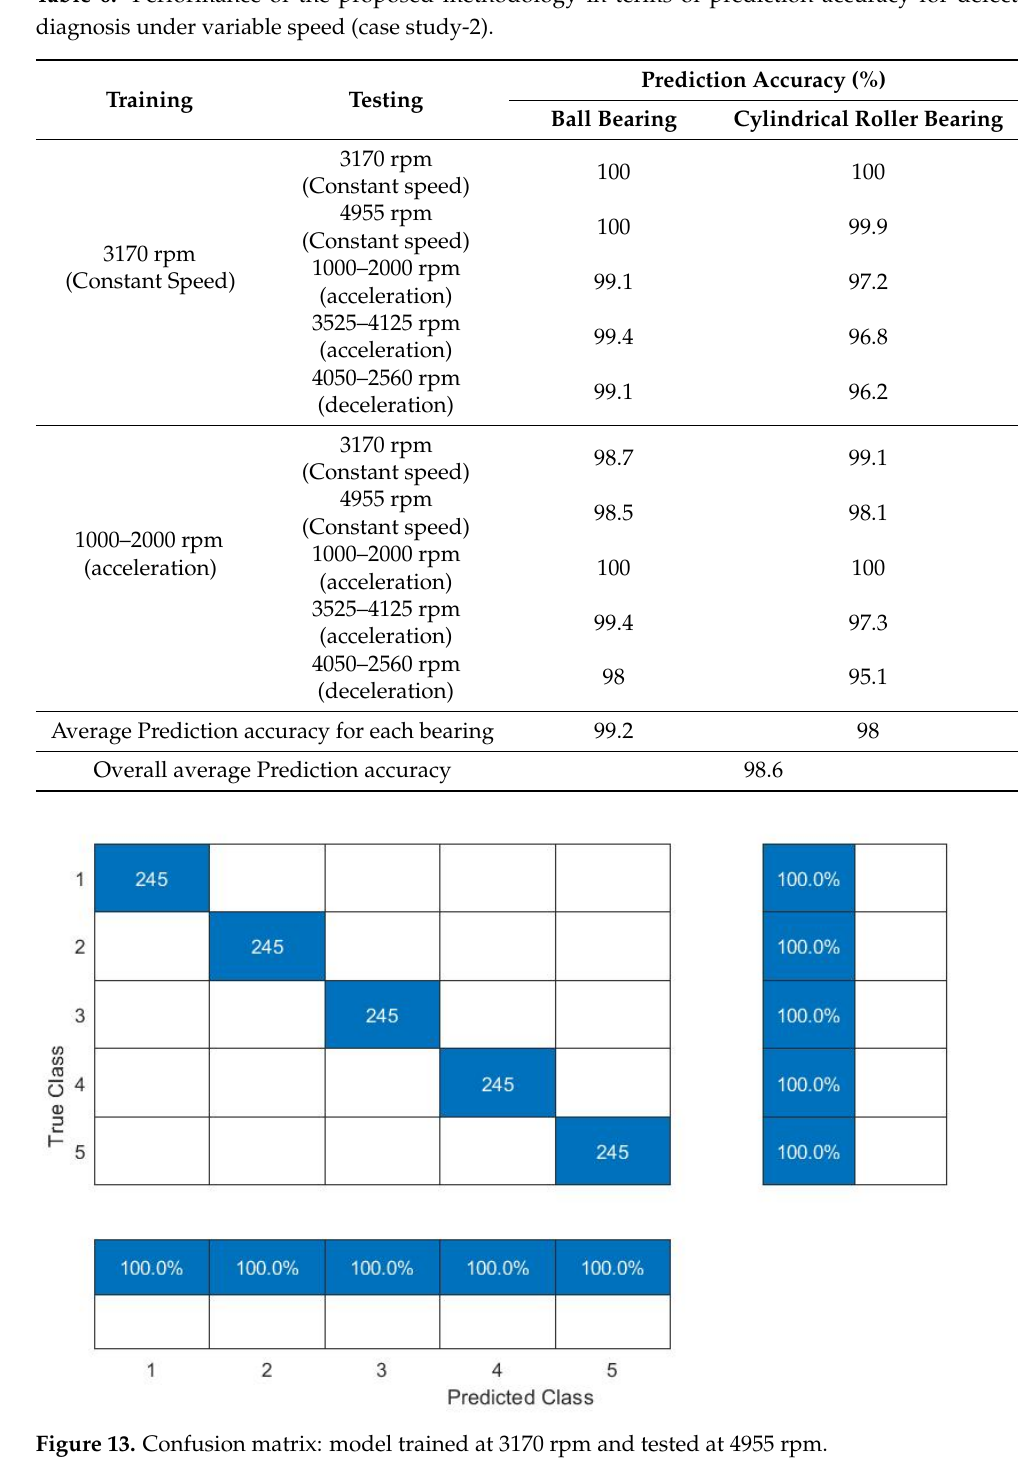
Figure 14. Confusion matrix: model trained at variable speed between 1000 and 2000 rpm and tested at variable speed between 3525 and 4125 rpm. 5. Conclusions In this study a method for the defect diagnosis of rolling element bearings under variable operating conditions (speed and load) using order maps and convolutional neural networks is proposed. A non stationery signal in the order domain. Short-time Fourier Transform of the resampled signal was computed to generate the order maps. These maps show consistent patterns under variable speed but different patterns for different types of defects. The sensitivity of order maps for changing load was studied experimentally for deep groove ball bearings and it was found that they remain consistent under varying loads if the bearings are properly loaded. Therefore, order maps can be termed as operating condition (speed and load) invariant but fault discriminative vibration images. In addition, due to this property, they can be used for fault diagnosis